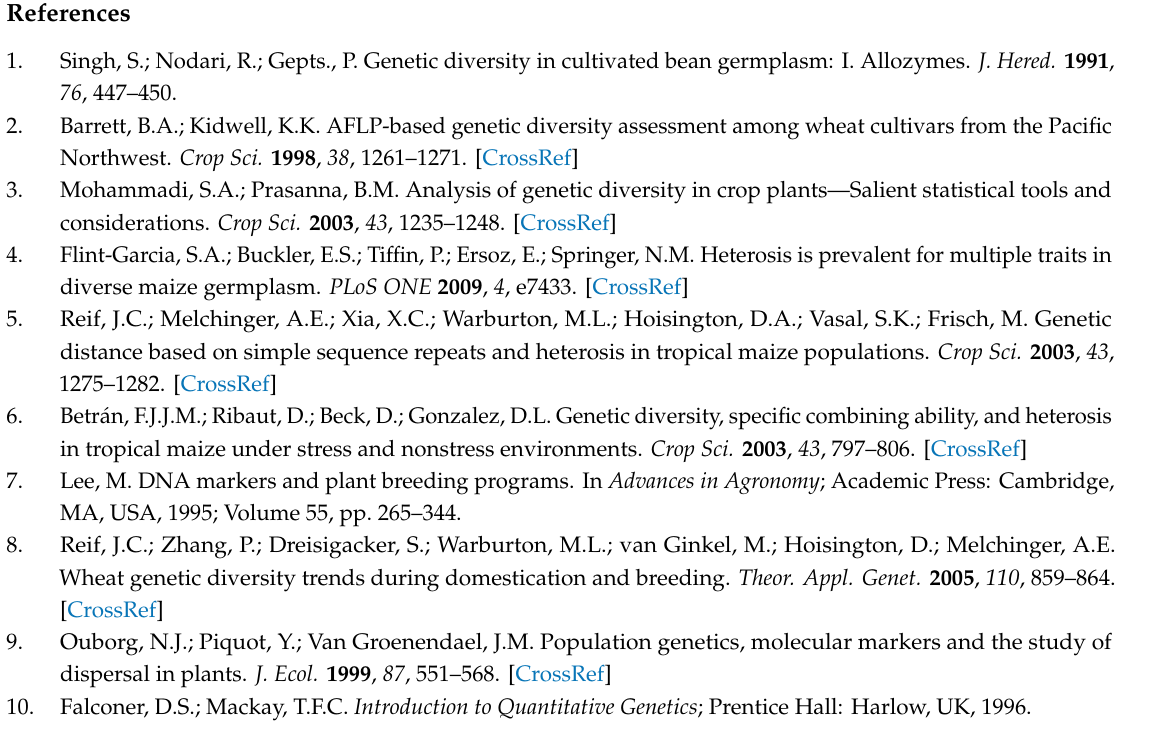
Table S1. Genetic distance matrix of the 162 yellow and white inbred lines using Euclidean method in the present study. Table S2. Summary of the 9684 SNP markers used in the current study. Table S3. a. Expected Heterozygosity of the 162 yellow and white inbred lines; b. Allele frequency divergence among populations with 162 inbred lines assessed and c. mean values of Fixation Index (Fs T ) of 162 yellow and white inbred